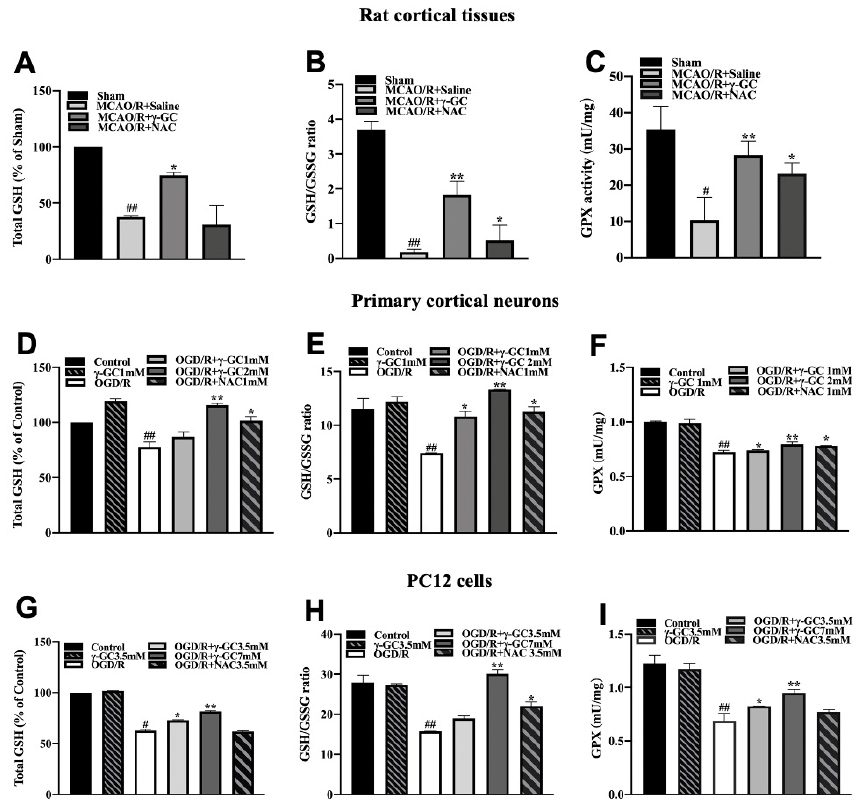
Figure 3. γ -GC increases the level of neuronal GSH. ( A – C ) Rats were administrated with γ -GC (688